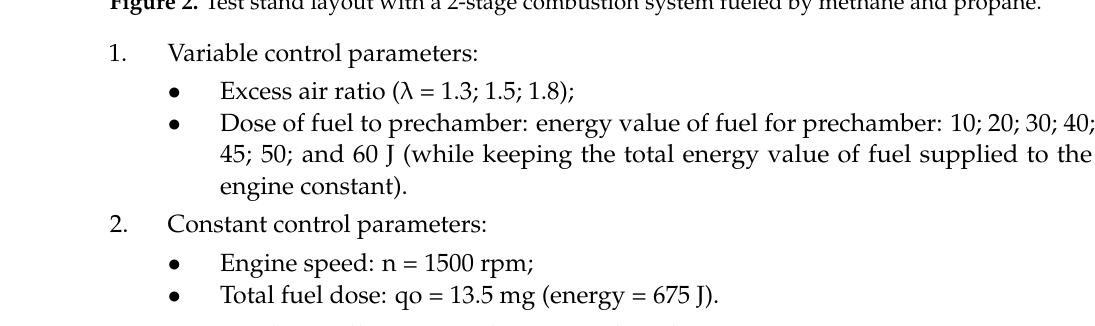
Figure 2. Test stand layout with a 2-stage combustion system fueled by methane and propane.